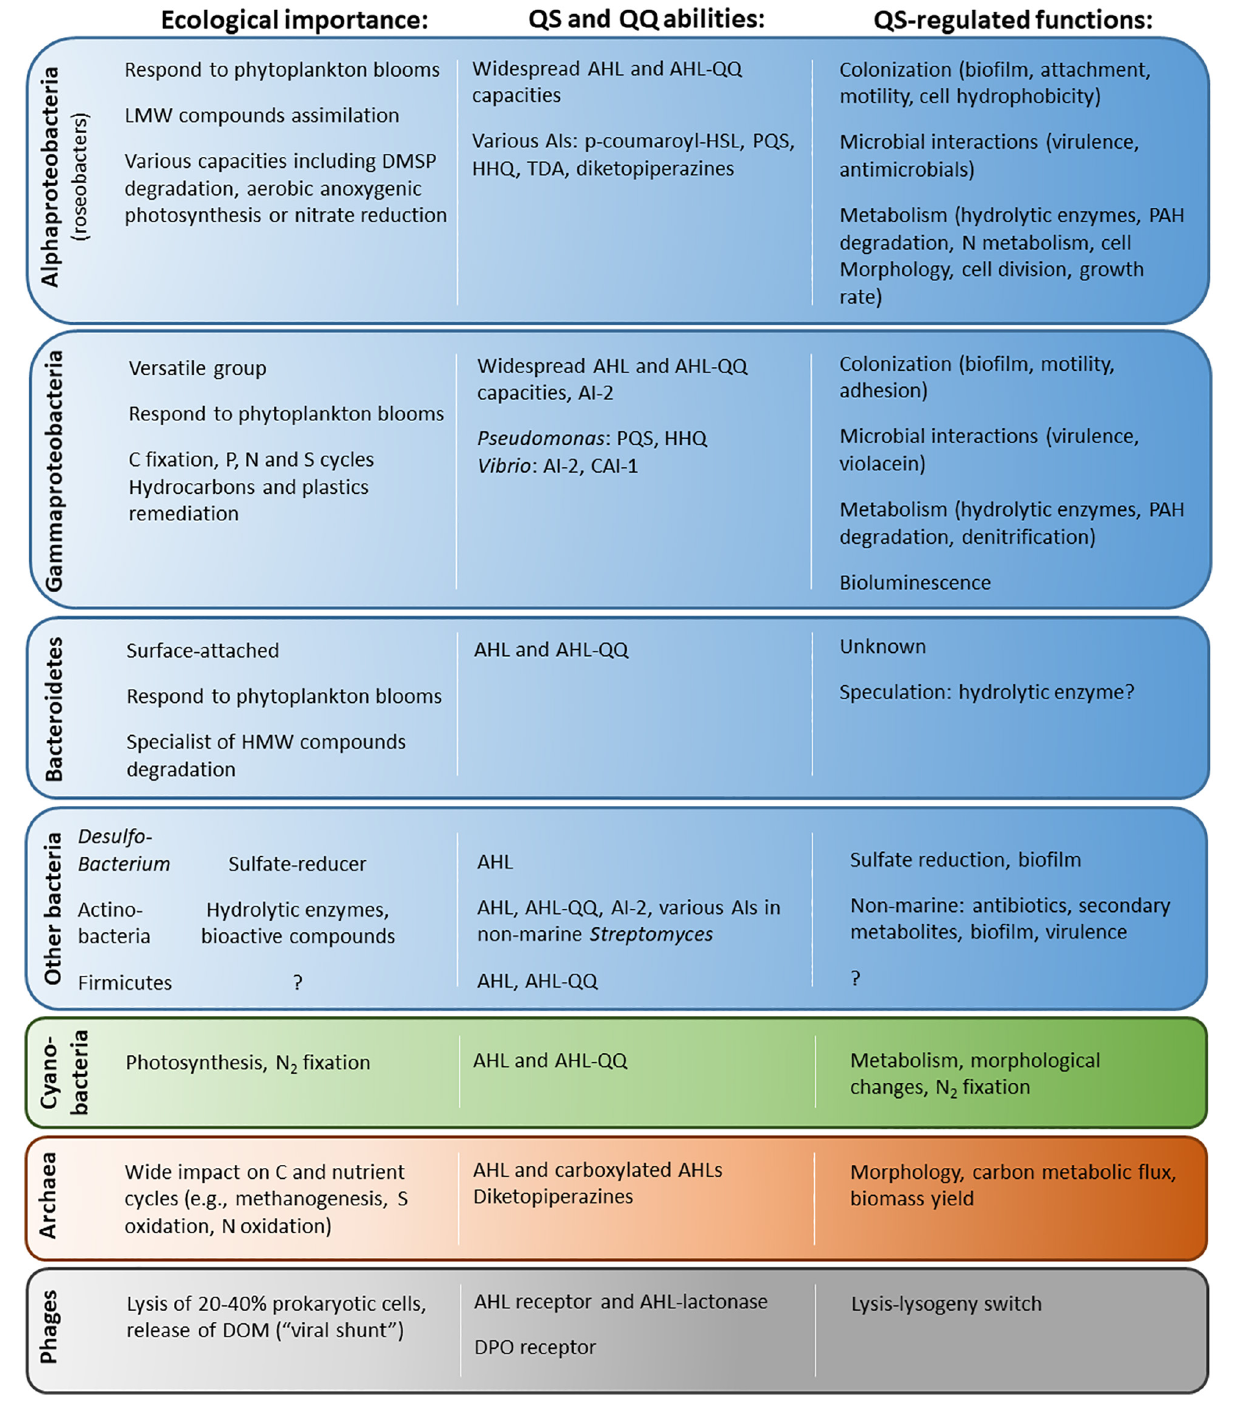
studies (Romero et al., 2012; Doberva et al., 2015; Huang et al., 2018; Muras et al., 2018; Su et al., 2021) are mostly affiliated with the roseobacter group (Rhodobacterales and